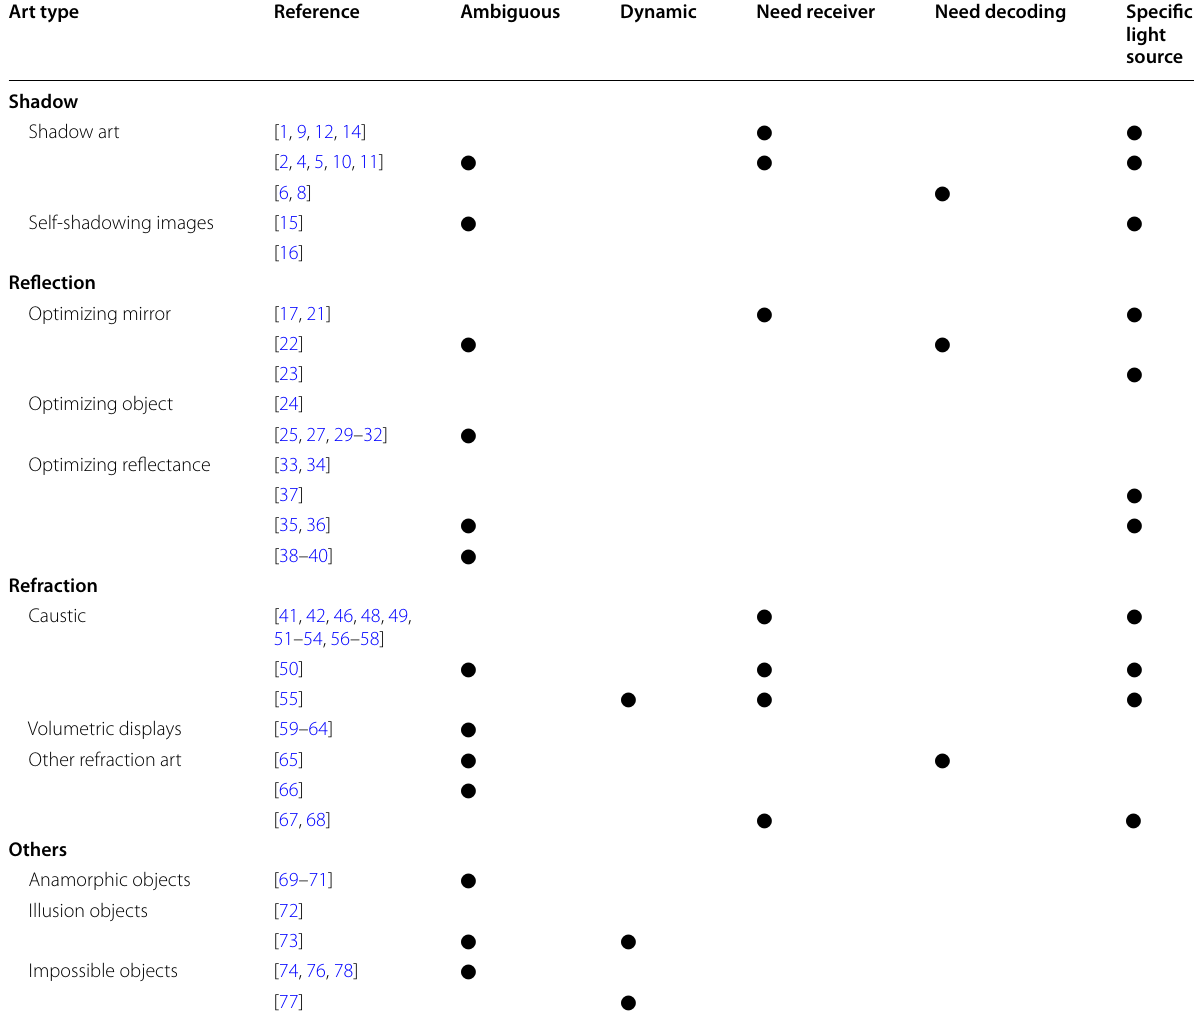
Table 1 Classification of the 3D visual optical arts reviewed in this